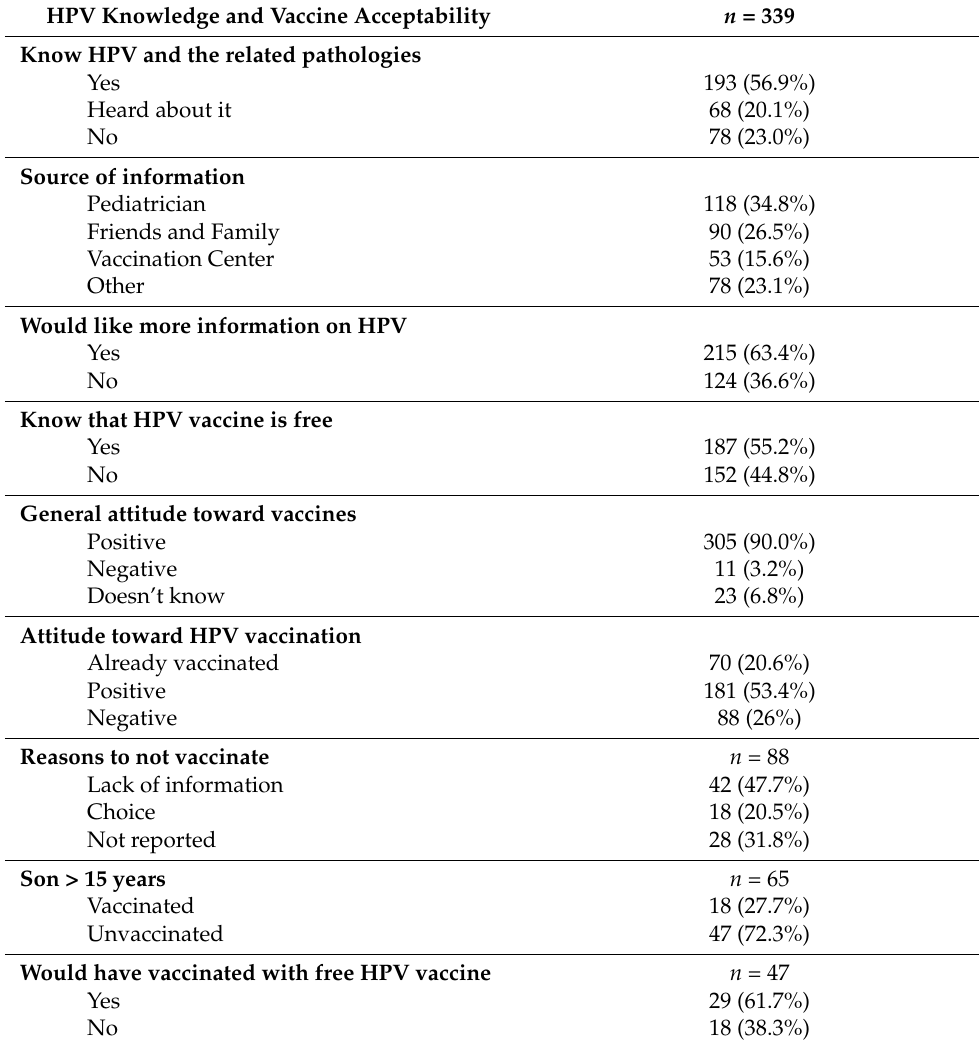
Table 2. HPV infection and vaccine